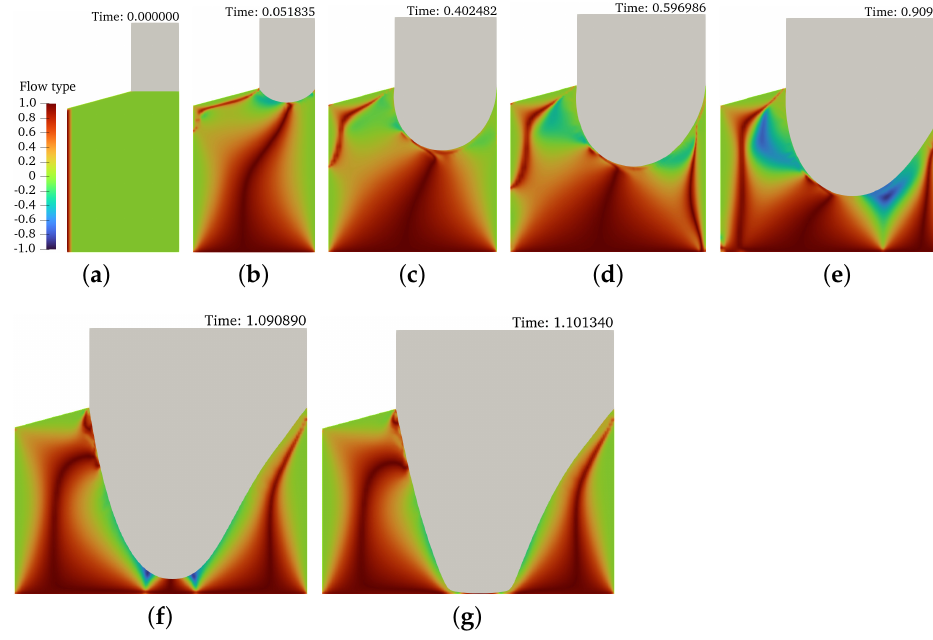
Figure 9. ( a – g ) The contour plots of flow type at different time steps for the simulation of Newtonian ink and the gravure velocity U = 2